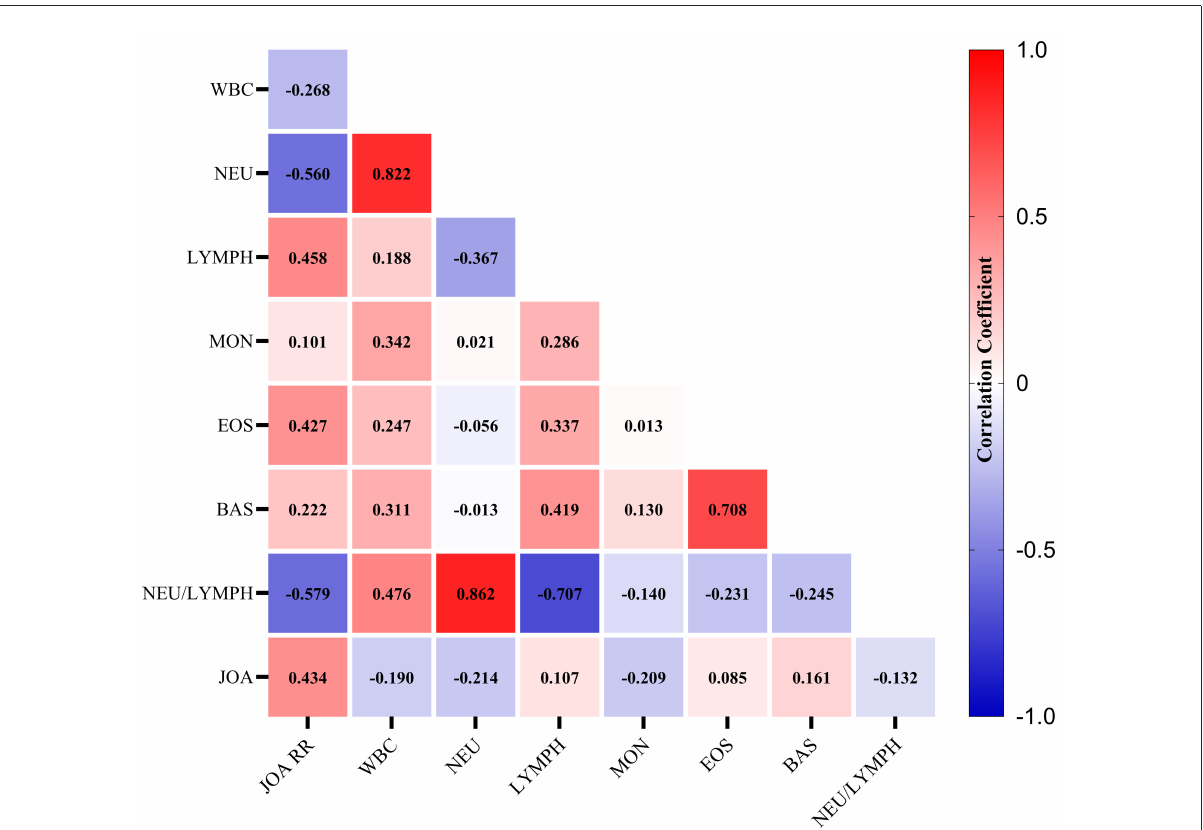
FIGURE1 The heatmap for the correlations among clinical measures. The correlation coefficients were given in the center of each square. WBC, white blood cell counts; NEU, neutrophils count; LYMPH, lymphocyte counts; MON, monocyte counts; EOS, eosinophils count; BAS, basophils count; NEU/LYMPH, neutrophils/lymphocyte